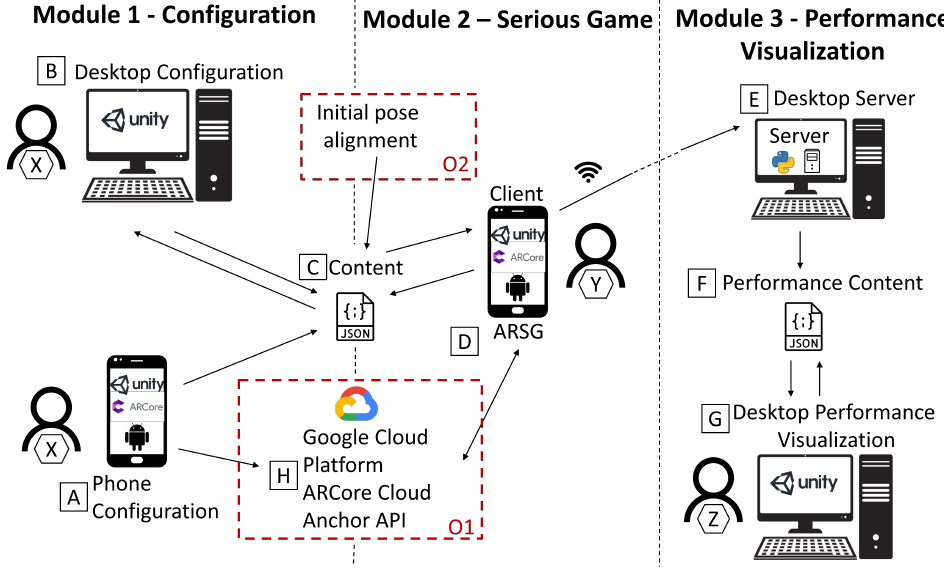
Figure 2. Architecture overview: A—configuration of the ARSG using the smartphone device; B—configuration of the ARSG using the computer; C—file generated in the configuration process containing the virtual information; D—visualization and interaction with the ARSG; E—server receiving messages from the ARSG; F—file with the user actions while playing the ARSG; G—display of user actions; H—API for storing cloud anchors; X—user performing the configuration; Y—user playing the ARSG; Z—user visualizing the user Y game performance; O1—requirement for motion tracking using the cloud anchor operating mode; O2—requirement for offline motion tracking operating